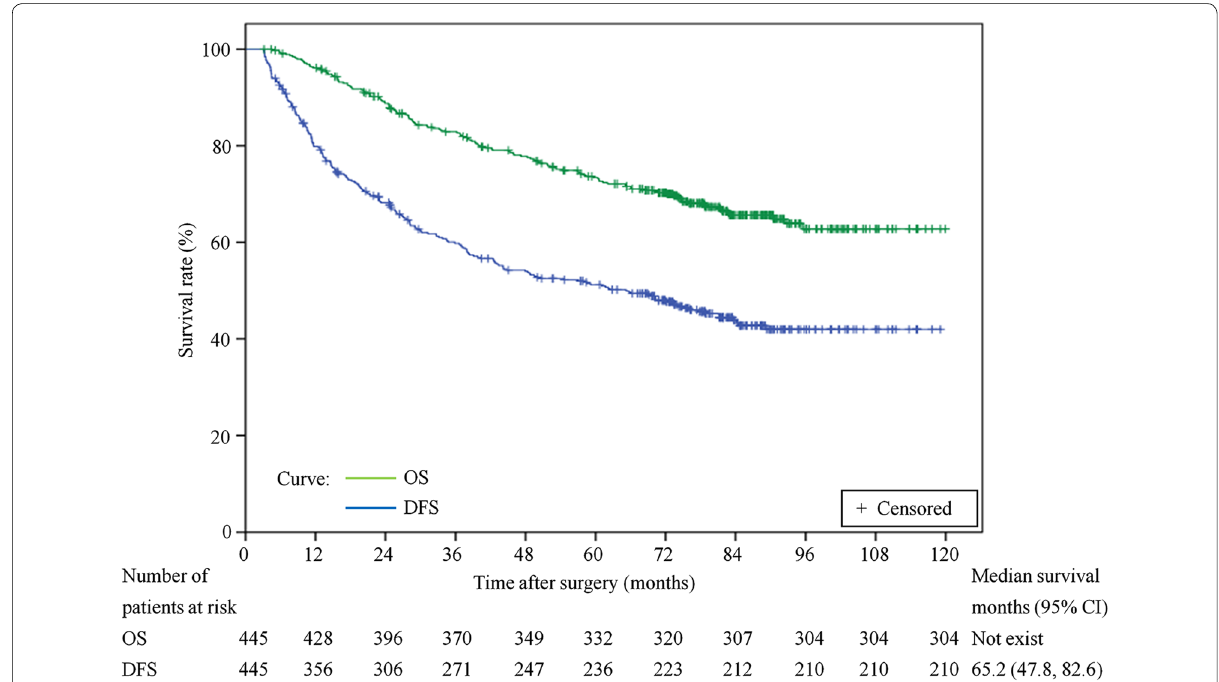
Fig. 2 Kaplan–Meier survival curves for overall survival (OS) and disease‑free survival (DFS) in patients who underwent curative resection ( n CI confidence